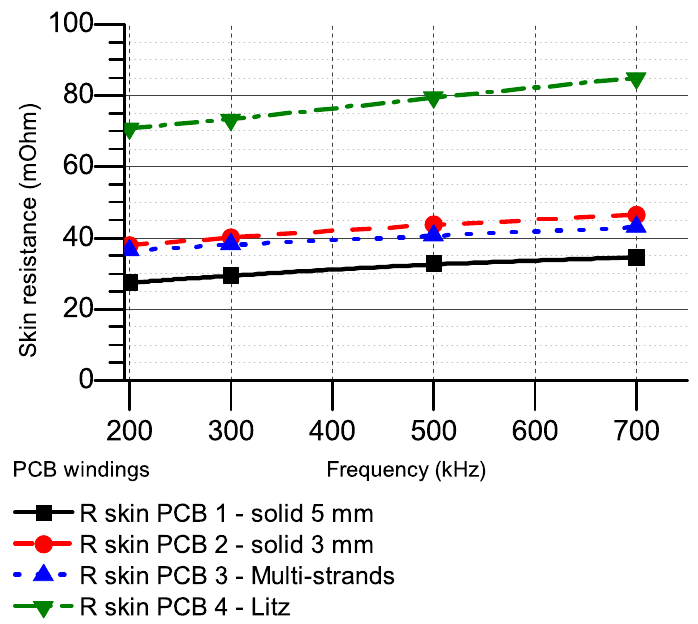
Figure 13. Calculated skin resistances of 3-turn windings.